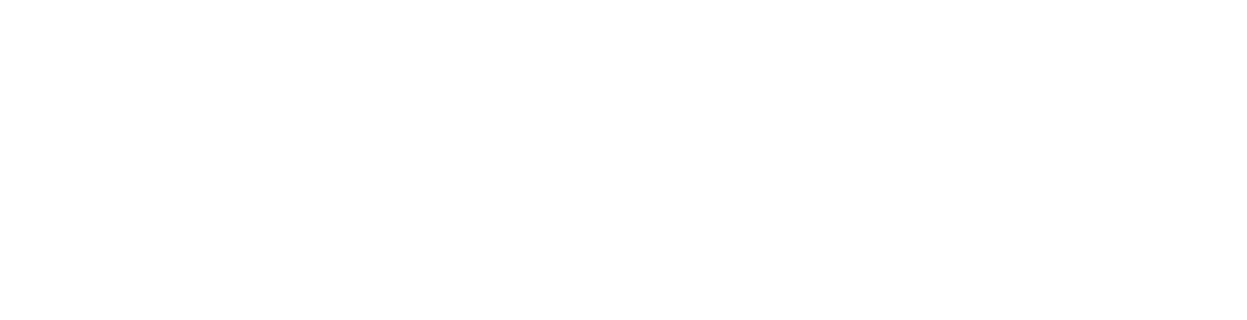
Frontiers in Endocrinology | Genomic Endocrinology February 2012 |Volume 3 | Article 29 |